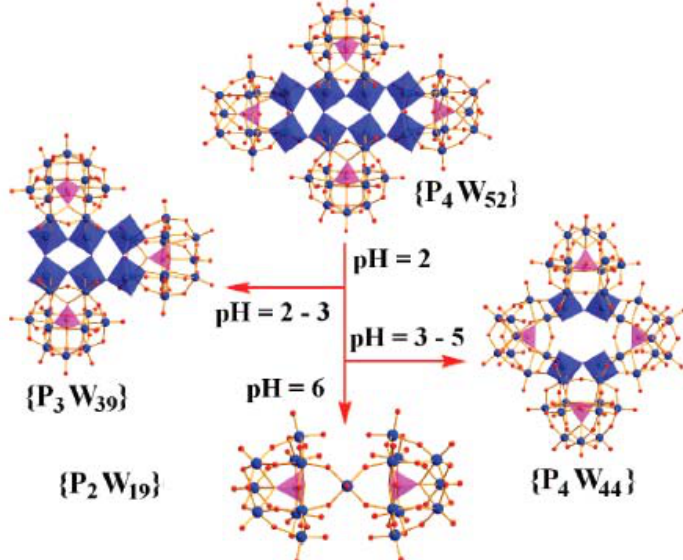
Fig. 15. Molecular structures of {P4W52} cluster anion and its pH controlled decomposition products. Adapted from Ref [71].